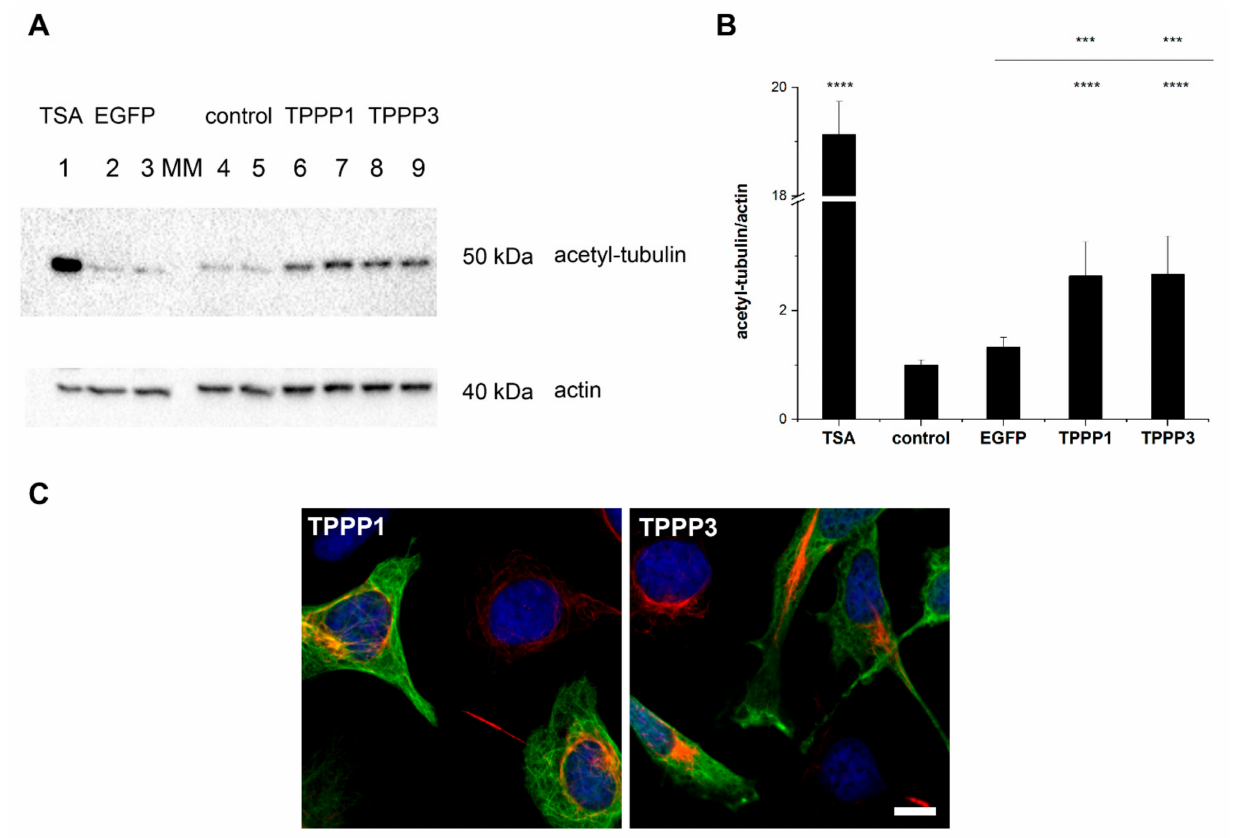
Figure 5. The promoting effects of TPPP3 and TPPP1 on the tubulin acetylation. ( A ) In Western blot experiment, the tubulin acetylation level was quantified by acetyl-tubulin antibody in